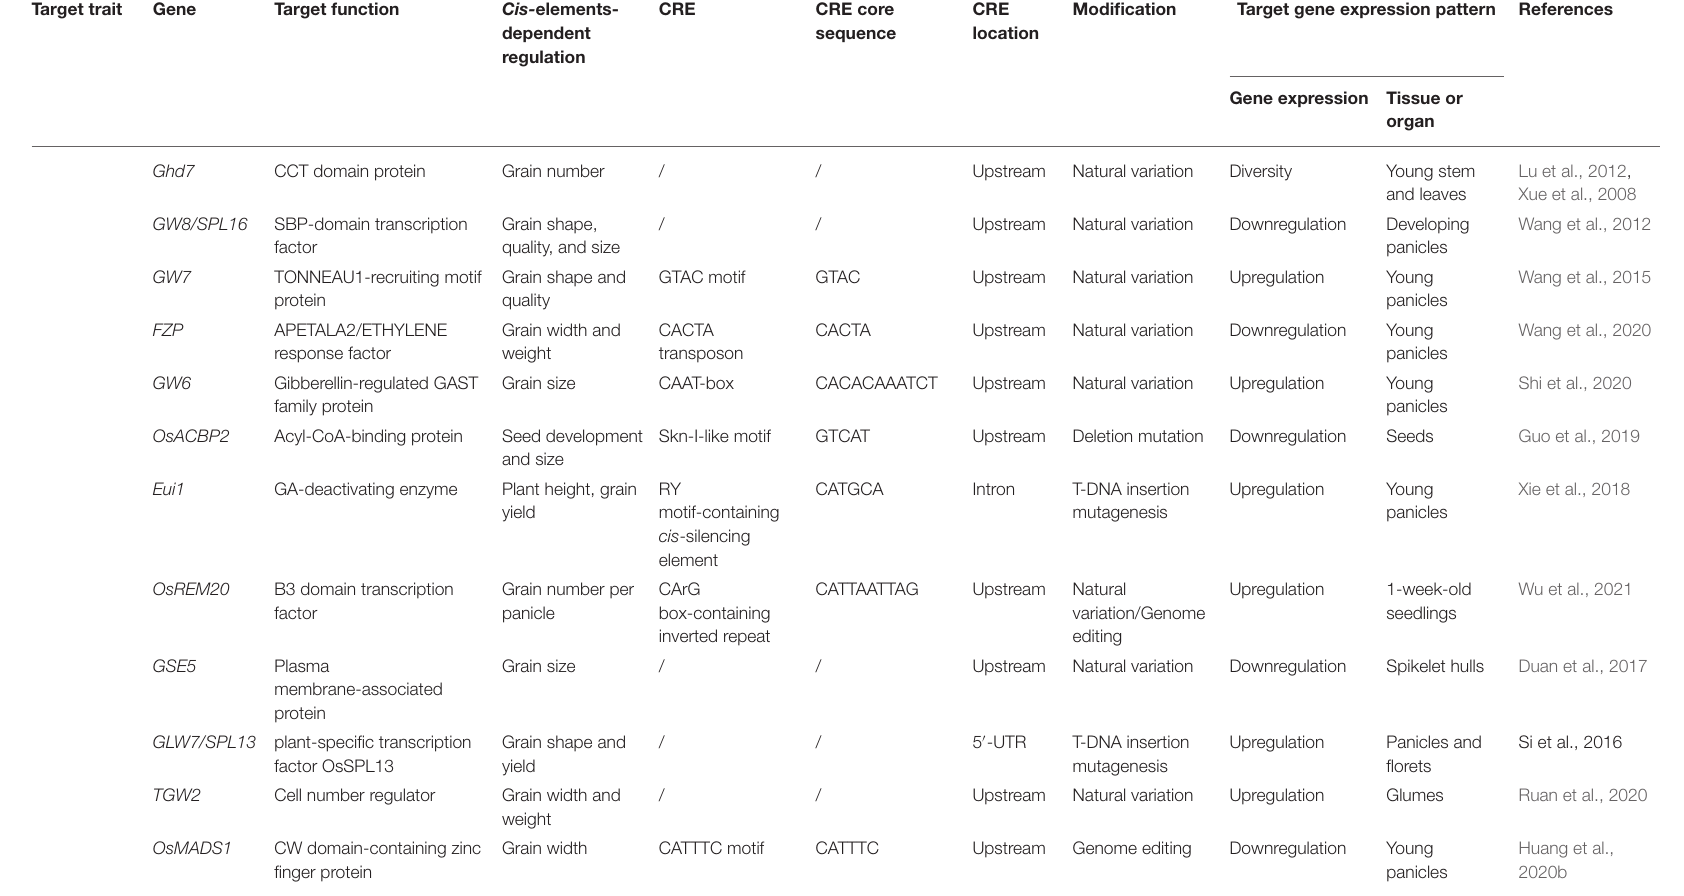
# Represents diversity in the regulation region of the target